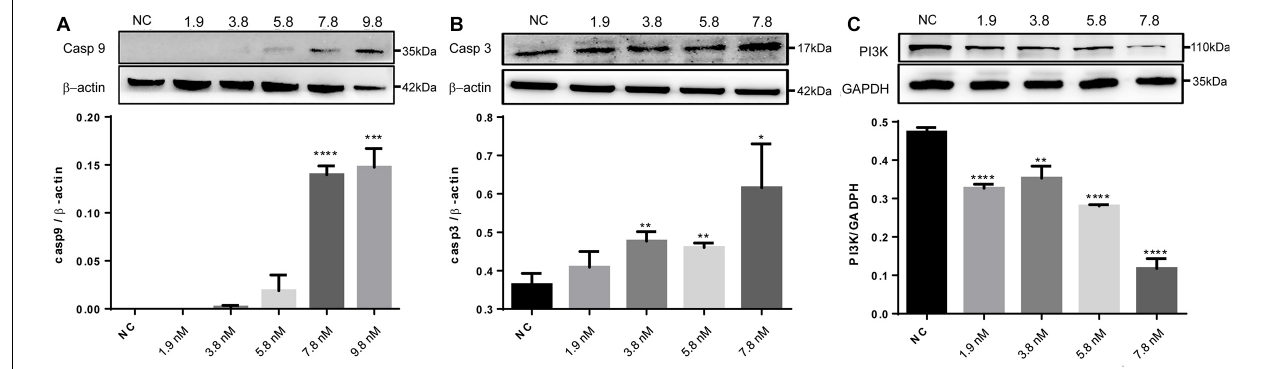
FIGURE 6 | Western blot analysis of CASP9, CASP3 and PI3K of HeLa cells after treated by caerin 1.1/1.9. 5 × 10 5 cells were either untreated or treated with different concentrations (5, 10, 15, 20, and 25 µ g/ml) of caerin 1.1/1.9 mixture (mass ratio 50:50) for 24 h. The gel lane areas corresponding to the molecular weights of target proteins and β -actin/GAPDH were cropped and subjected to the first antibody treatment, respectively. Bound antibody was detected by incubation of the membrane with horseradish-peroxidase conjugated goat anti-rabbit/mouse antibody (PTG) at a dilution of 1:1000 and visualized using enhanced chemiluminescence and visualized by an image scanner ProteinSimple. The experiment was performed in triplicate and one representative blot was quantified, (A) CASP9, (B) CASP3, and (C) PI3K, with the original gel images shown in Supplementary Figure 13 . A two-tailed Student t -test was used to calculate P -values: * P < 0.05, ** P < 0.01, *** P < 0.001, **** P <